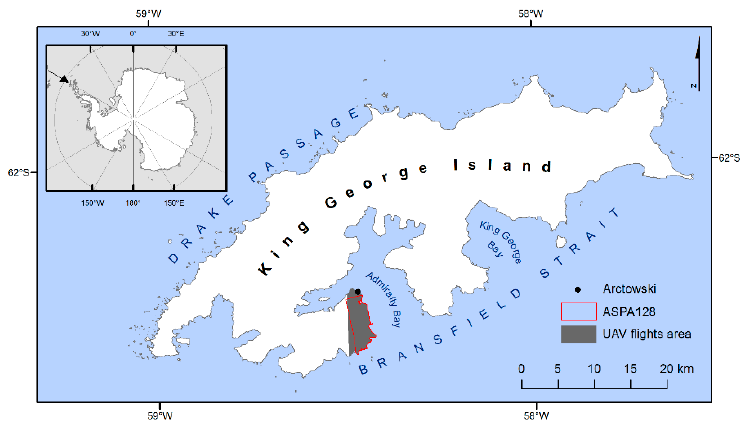
Figure 1. Location of King George Island, Antarctic Specially Protected Area No. 128 and the unmanned aerial vehicle flights.